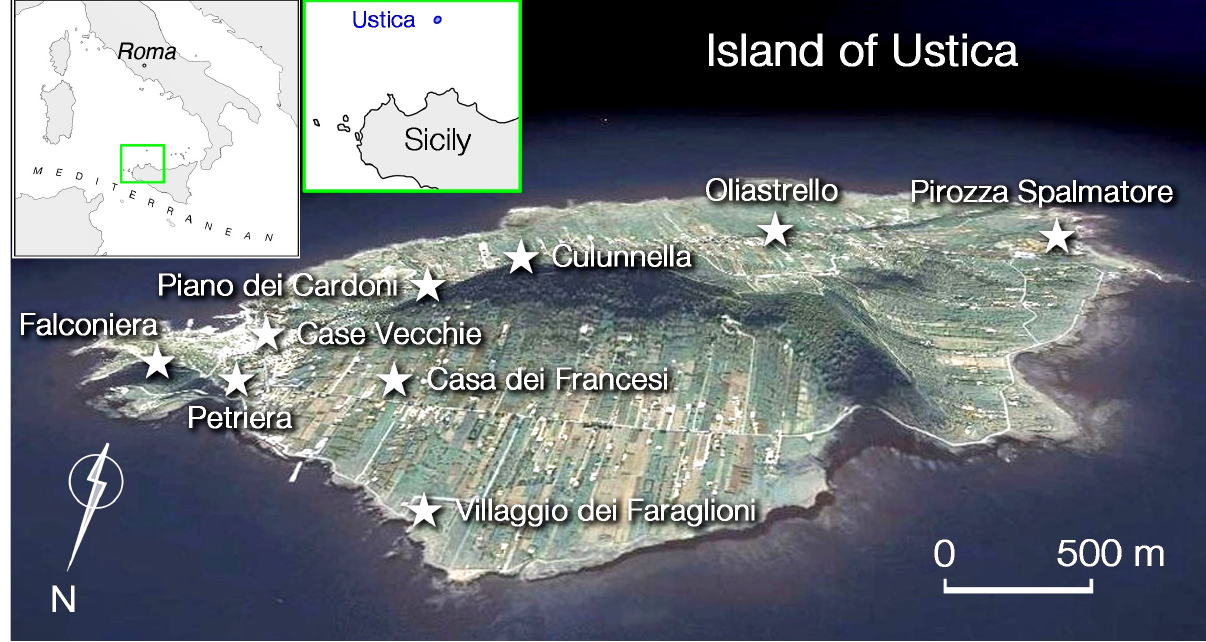
Figure 1: Satellite view of Ustica Island (Sicily, Italy) with the main prehistoric settlements so far identified. The obsidian fragments analyzed in this work were collected on the surface of an agricultural field near Casa dei Francesi, in the eastern side of the vast Tramontana Plain, where any prehistoric site has been reported until now (modified from Google